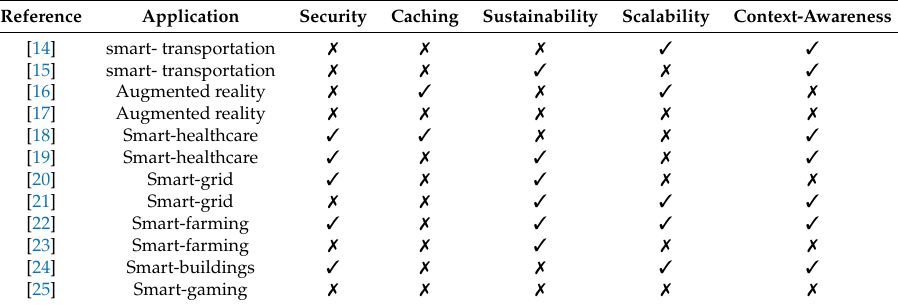
Table 1. The review of fog computing techniques for various applications.